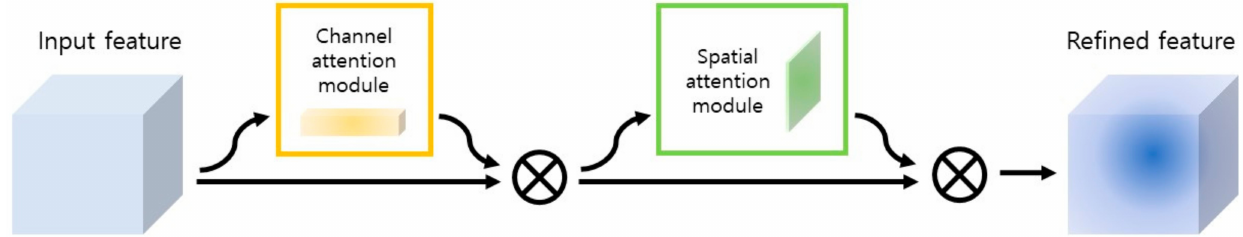
Figure 5. Overview of